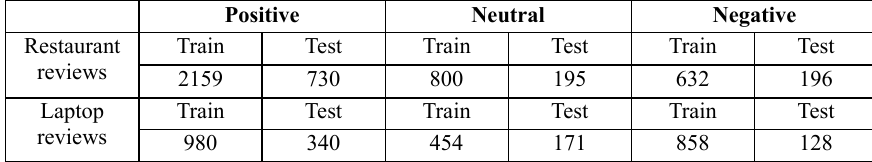
Table 1. Basic information of data set division.